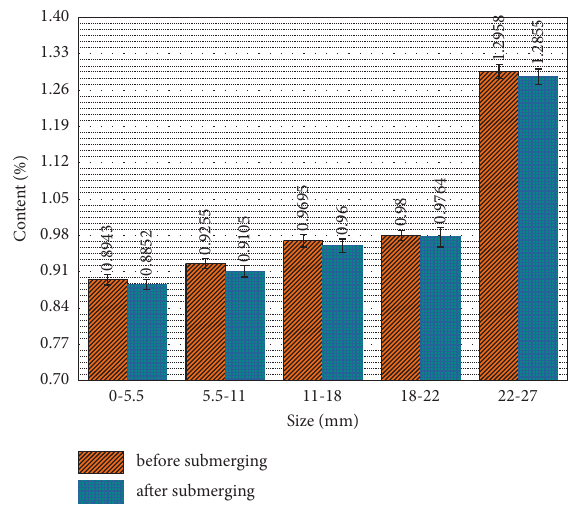
Figure 2: Content of free calcium oxide in steel slag with different particle sizes.